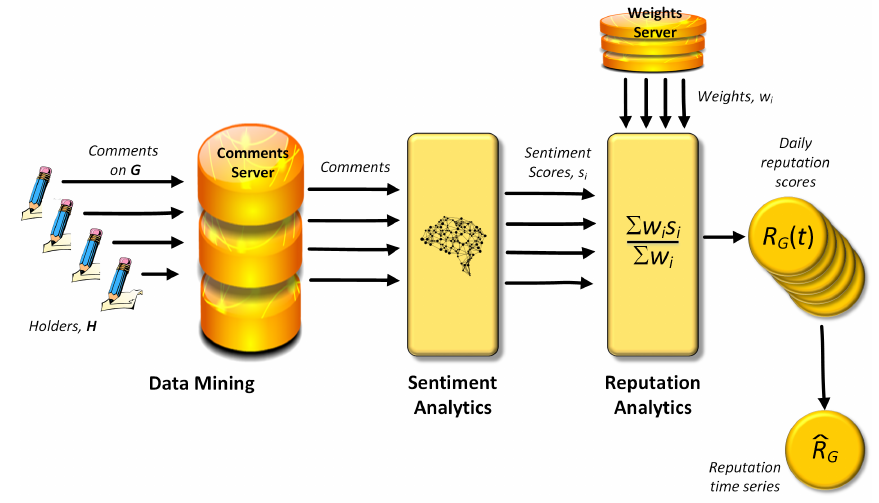
Figure 1. The stages in the process of reputation